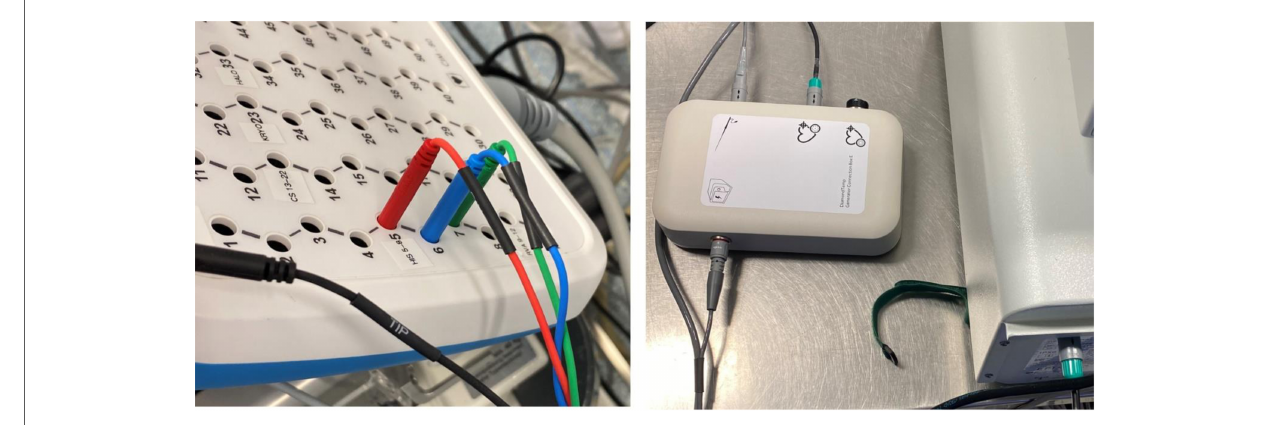
FIGURE 4 Con fi guration 3.2 details. Electrogram (EGM) out cable connected to the Genconnect and to the EnsiteX CIM pins 2 –